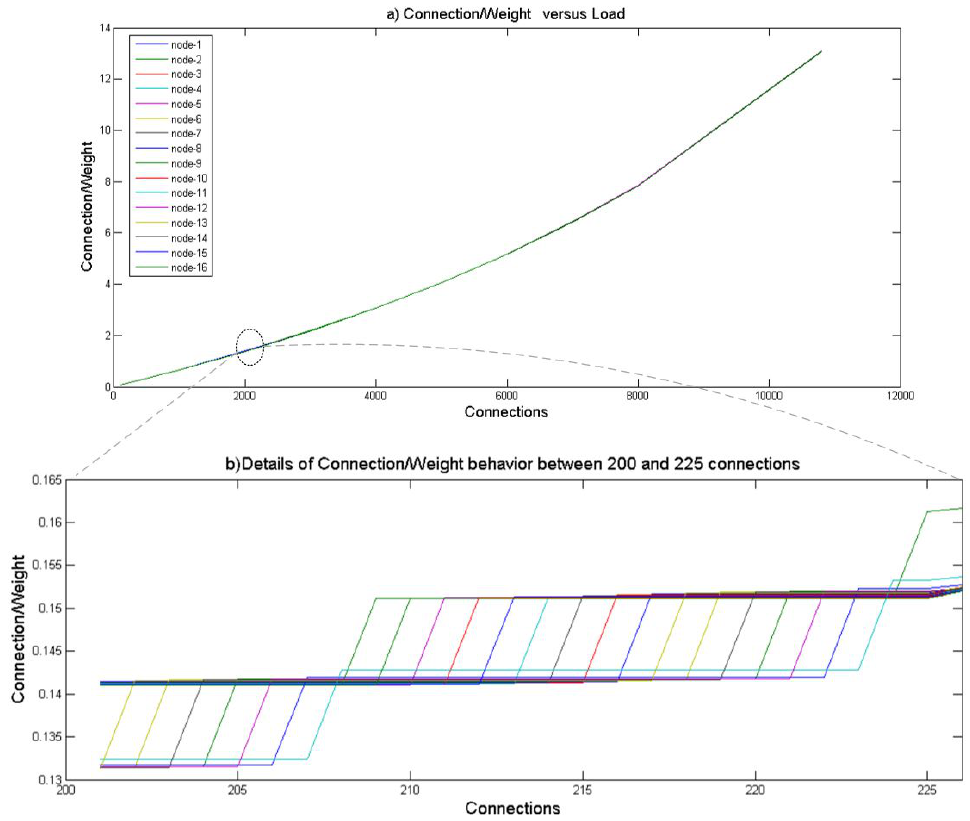
Figure 8. Nodes with different resources: C i / W i .